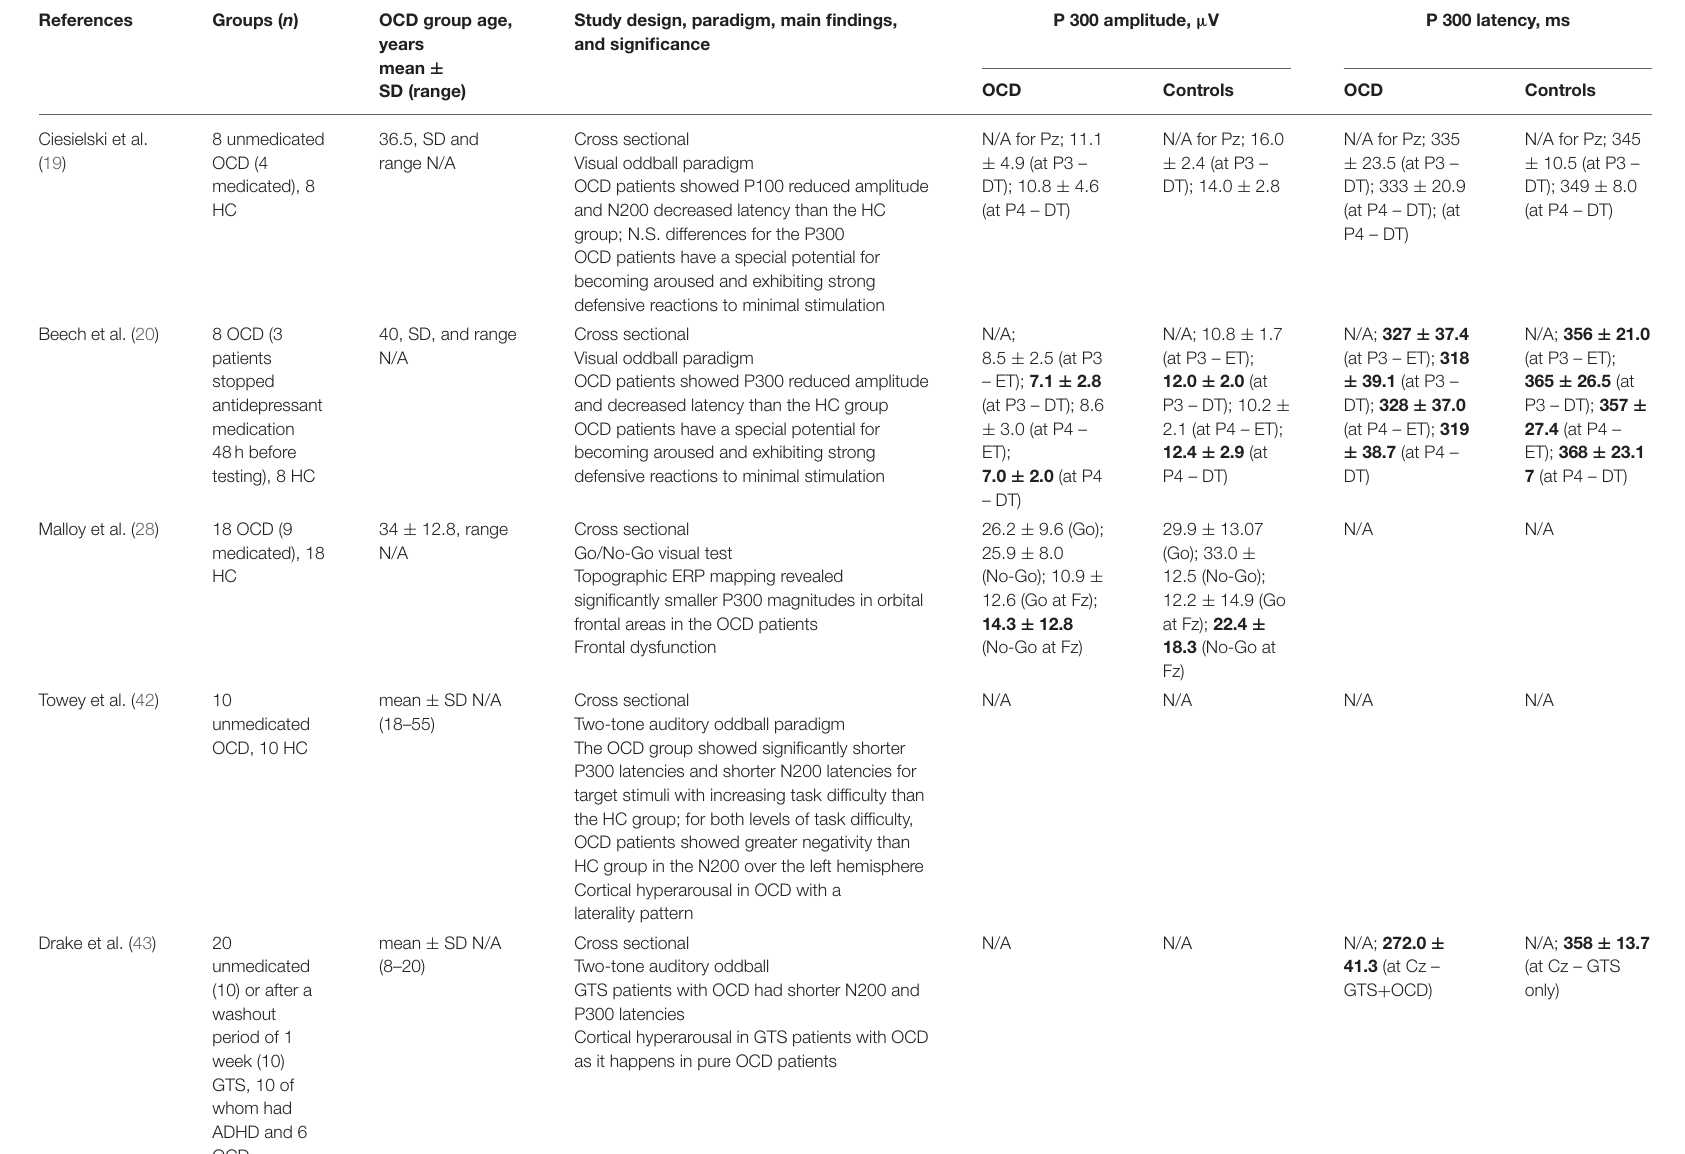
TABLE 1 | Studies investigating P300 in patients with obsessive-compulsive disorder and P300 parameters at Pz (usually the lead with the largest